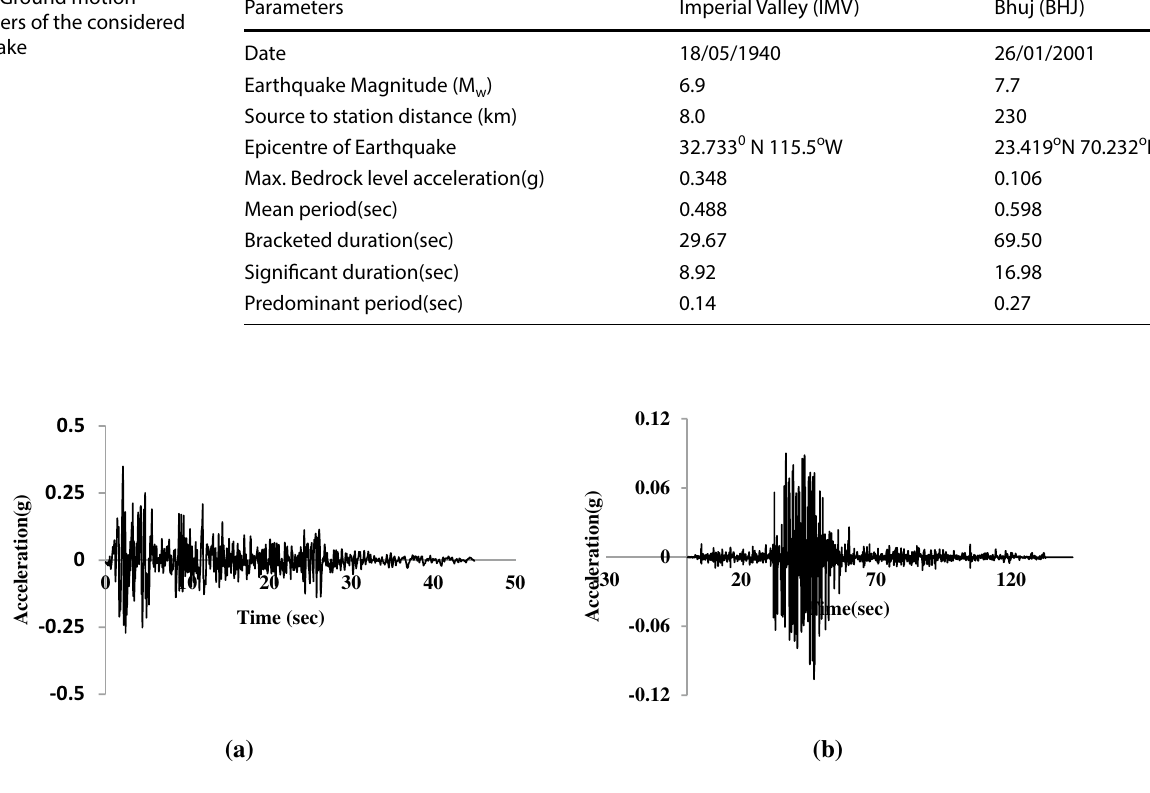
Table 4 Ground motion parameters of the considered